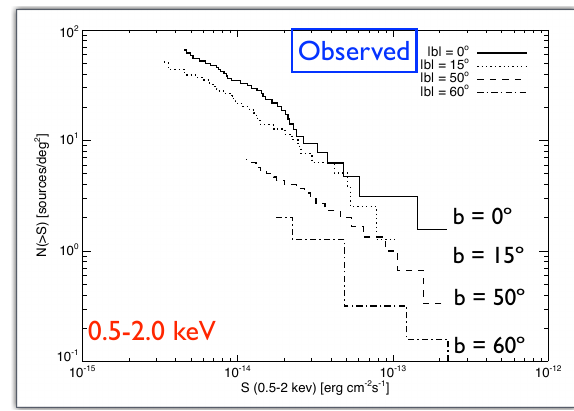
logN – logS curves in the soft band